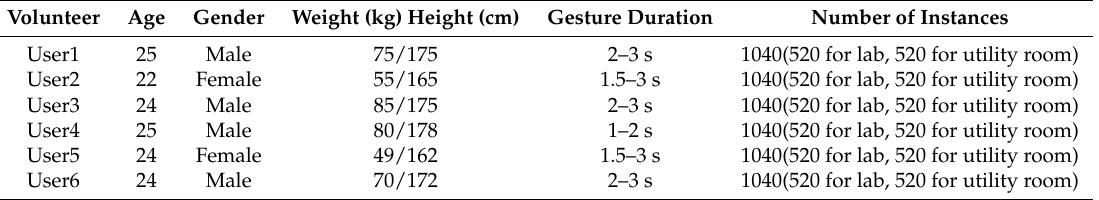
Table 3. Data collection uummary.